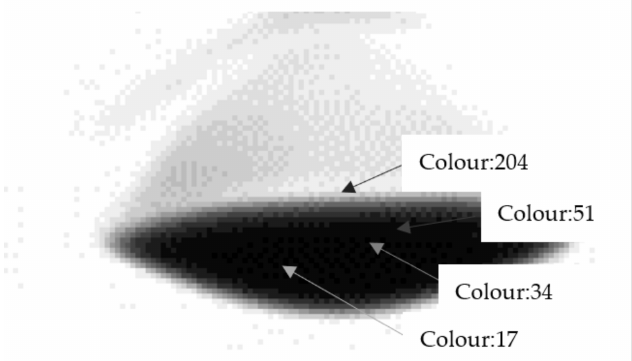
Figure 8. Pixel colour variation for a Sample 2 image.